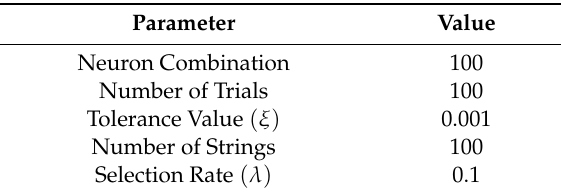
Table 1. List of parameters used in Hopfield Neural Network-Random 2 Satisfiability Exhaustive Search (HNN-RAN2SATES) [37].